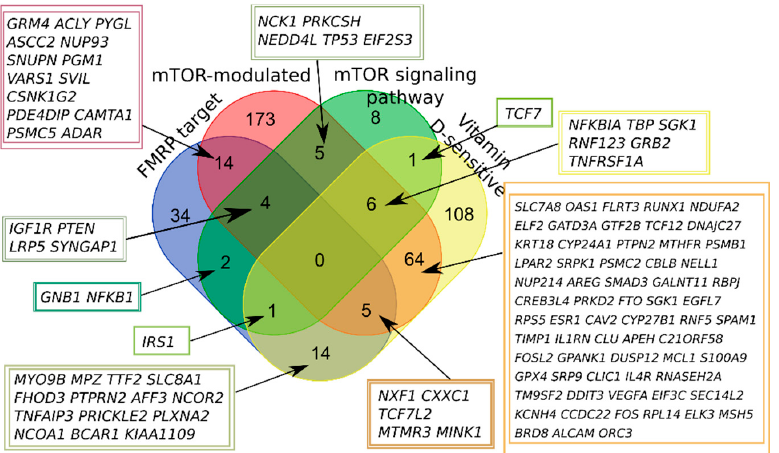
Figure 2. Venn diagram representing the relationship of the four categories related to the mTOR signaling and vitamin D-sensitive genes. All sets of genes were preliminarily intersected with whole AID gene set.